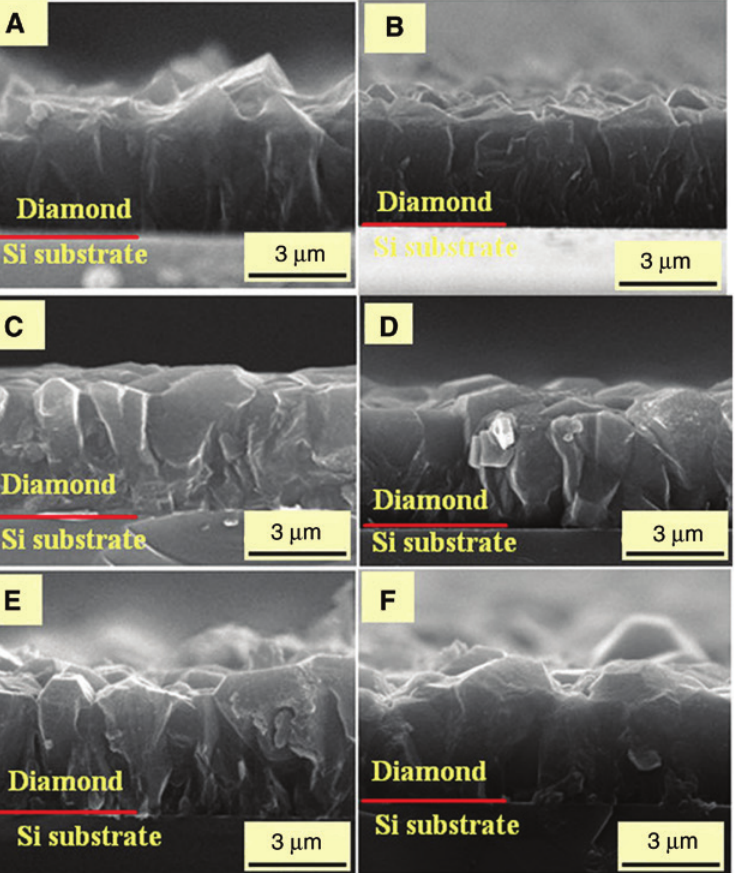
-0, Ar-0; (B) O -0, Ar-15; 2 2